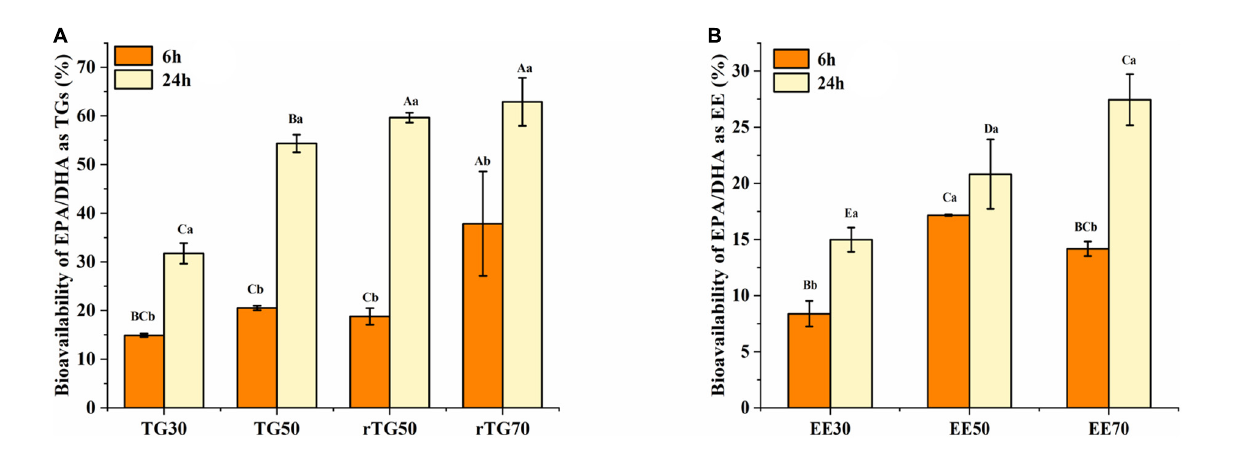
FIGURE7 The bioavailability of EPA/DHA as (A) TGs and (B) EEs with different purities. Data represents mean ± SD ( n = 3). Different letters (a, b) indicate statistically significant differences among 6 h and 24 h transport time ( p < 0.05). Different capital (A, B, C ... ) represent significant differences among the 7 fish oils at the same transport